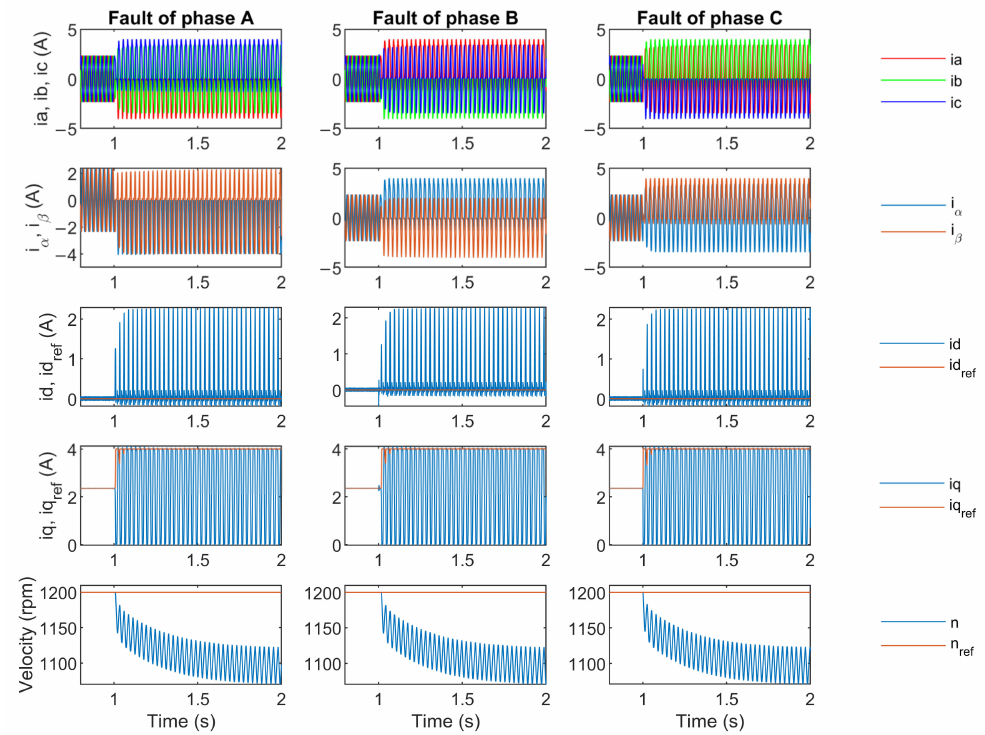
Figure 5. Simulation data collected after the fault of the upper switch in phases A, B, or C of the 6S3P